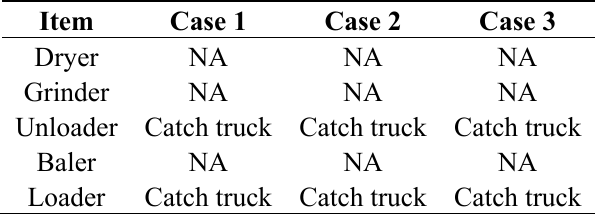
Table B4. Equipment and other elements used in